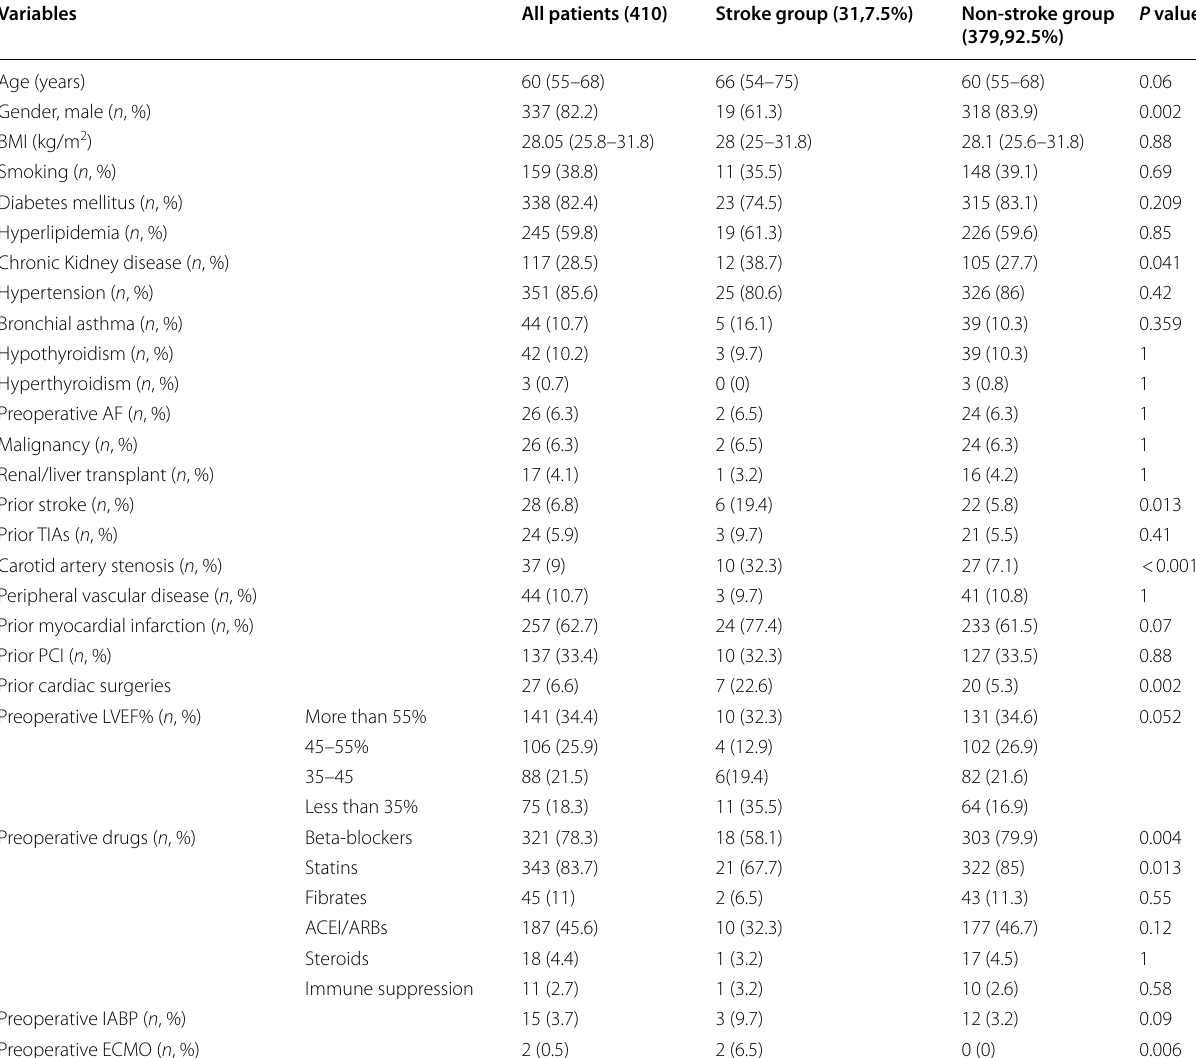
Table 1 Characteristics and profiles of